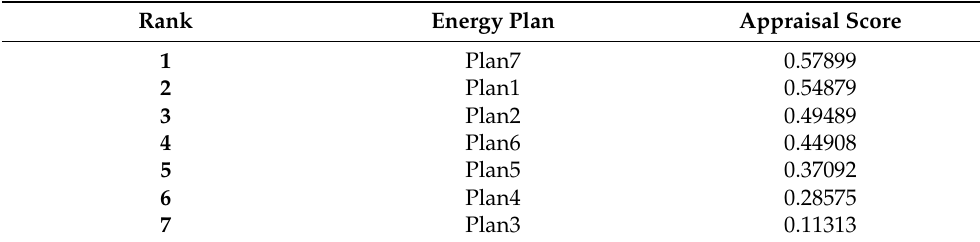
Table 9. Final appraisal score and ranks for seven energy